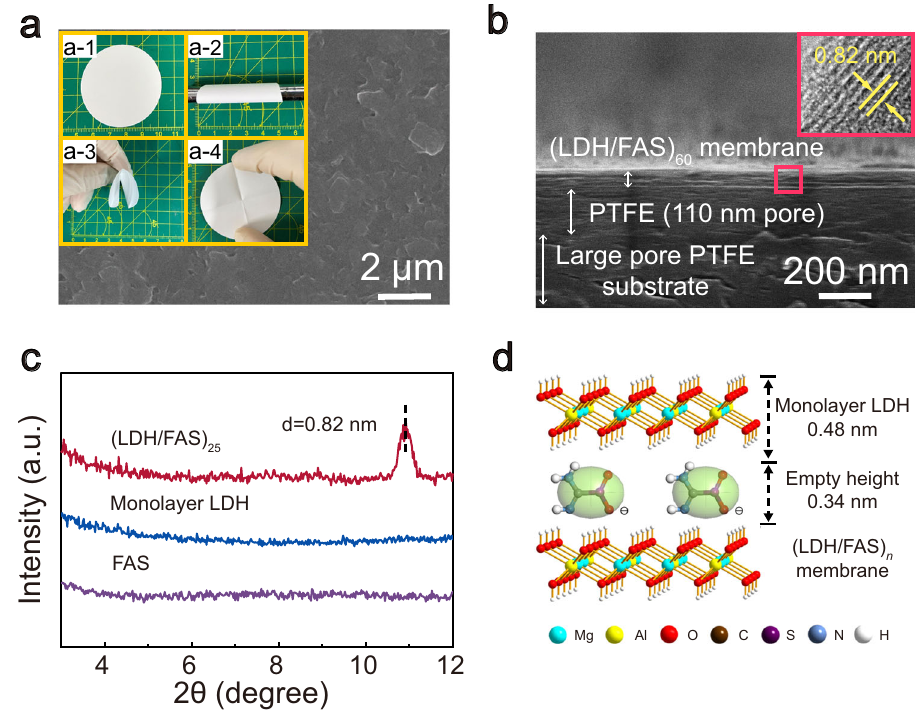
Fig. 3 Morphology and structure of (LDH/FAS) n membranes. a Top-view SEM image of (LDH/FAS) 25 membrane (The inset photographs show the membrane can be rolled onto a tube and returned to its original shape after bending.). b Cross-sectional SEM image of (LDH/FAS) 60 membrane (inset: HRTEM image). c XRD patterns for FAS, monolayer LDH nanosheets and (LDH/FAS) 25 membrane. d Schematic diagram of one bilayer of